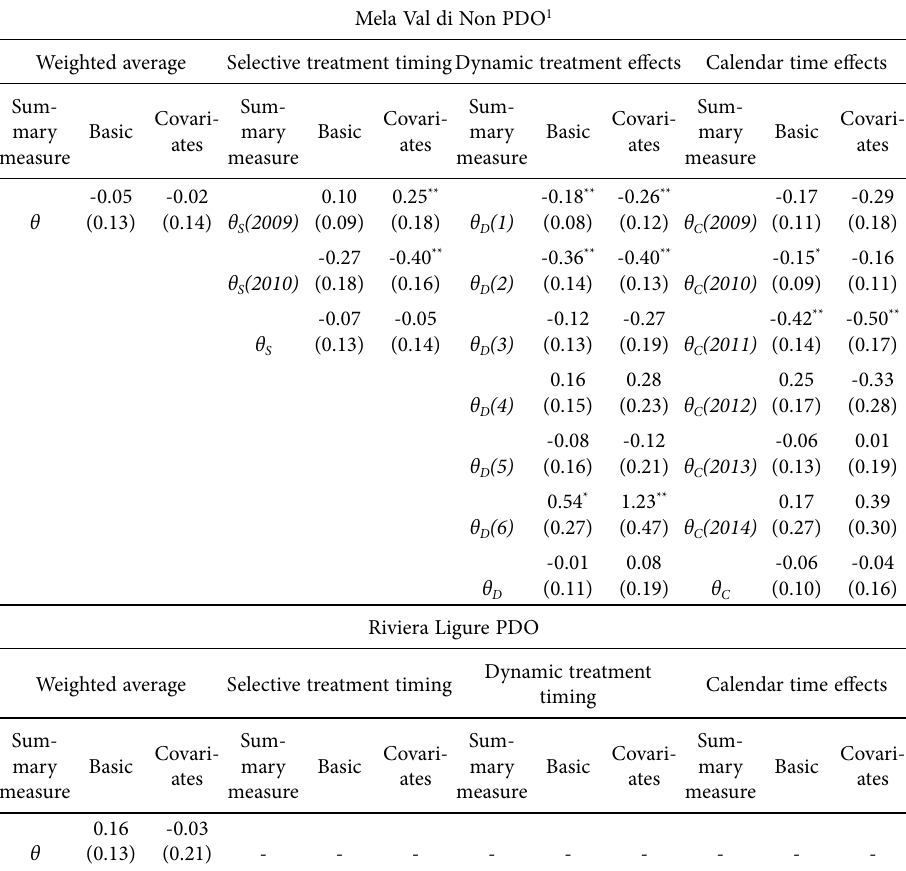
Table 5. CSA summary measures for Mela Val di Non PDO and Riviera Ligure